Question: What visual encoding does this figure use to show its data?
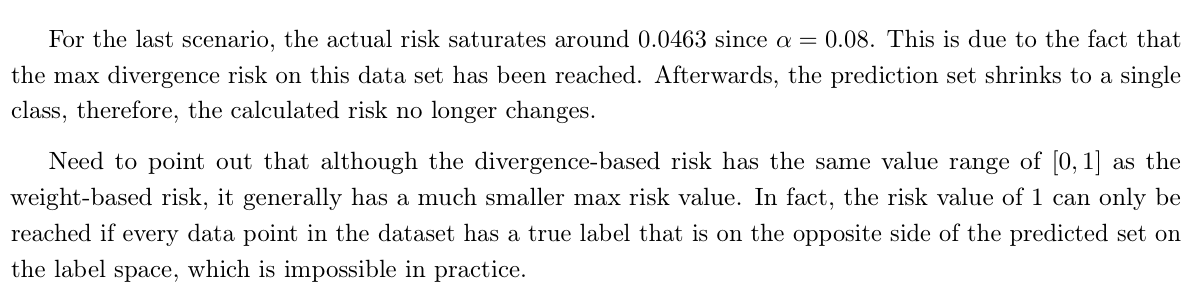
Answer: line